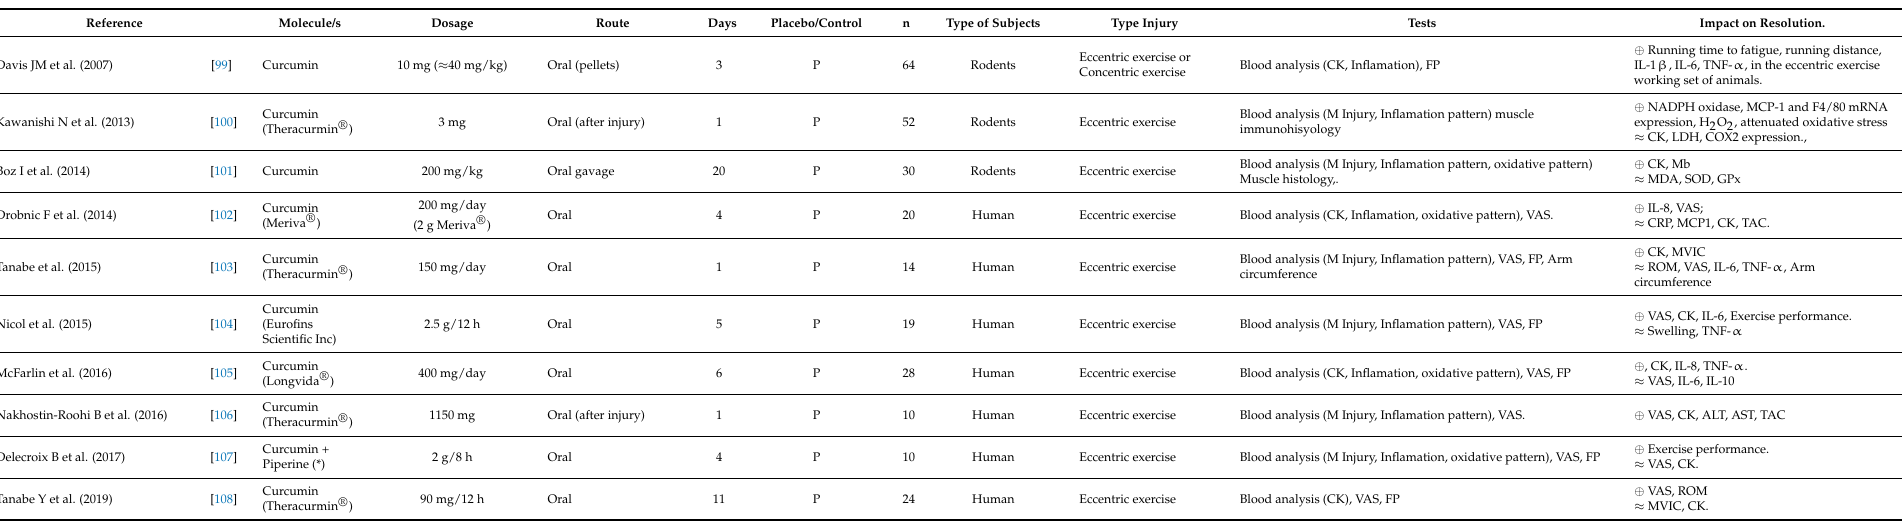
Table 1. Studies evaluating the effect of curcumin in miotendinous junction related to DOMS.